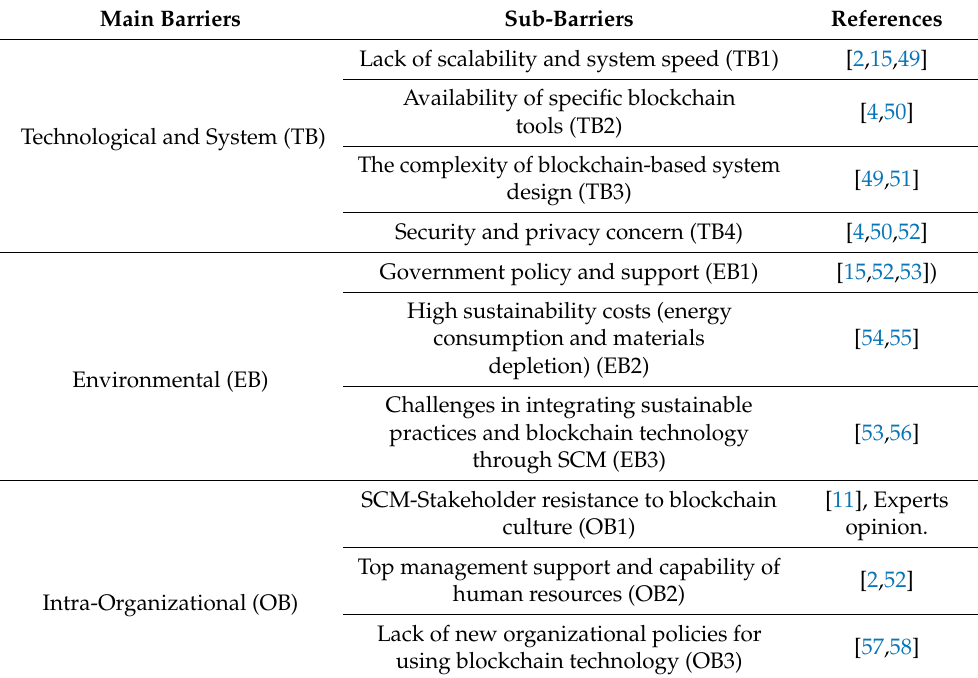
Table 4. Summary of main barriers and sub-barriers for blockchain adoption and related